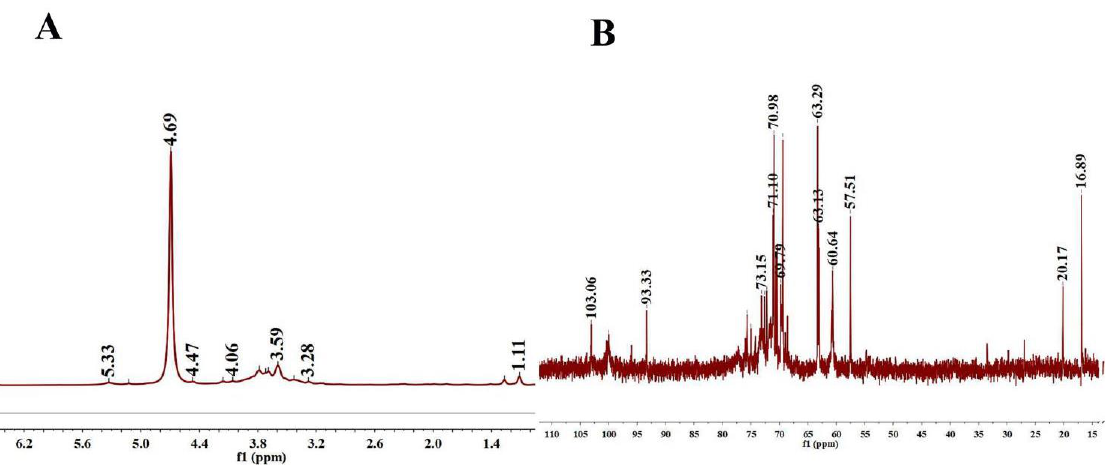
Figure 2. NMR spectra. ( A ) 1 H-NMR spectra of PLE and ( B ) 13 C-NMR spectra of PLE. PLE: Polysac- charides of L. edodes ; NMR: Nuclear magnetic resonance.